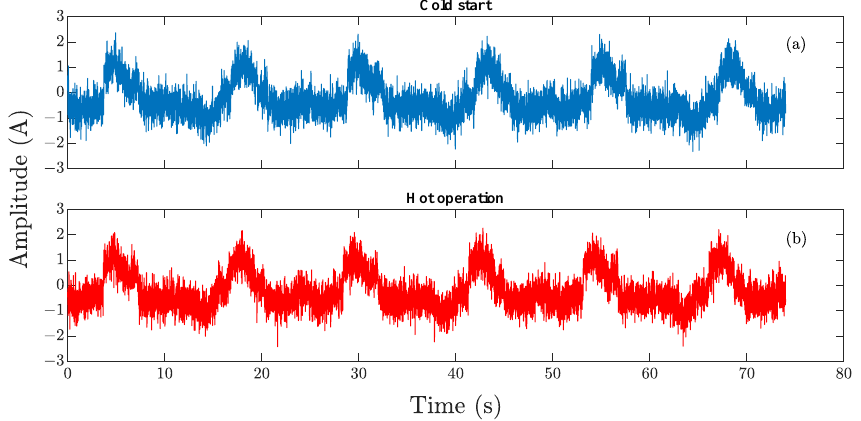
Figure 7. Current signals of joint one with 5 dB noise: ( a ) signal for the robot cold-start state; ( b ) signal for the robot hot-operation state.